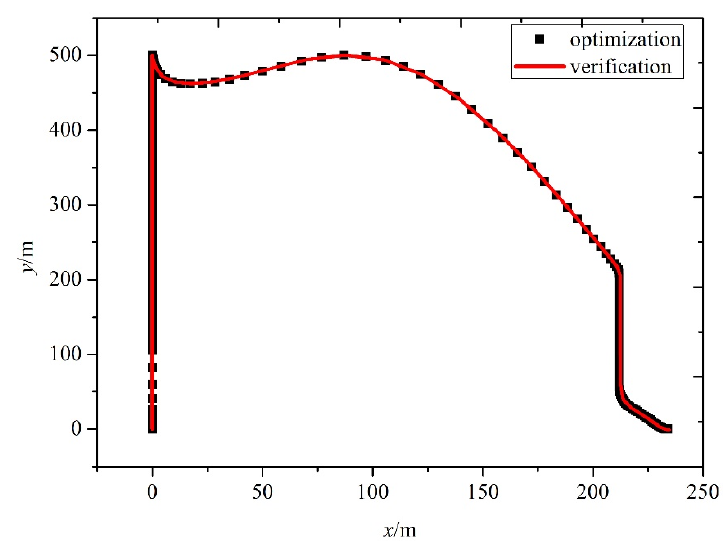
Figure 17. Flight trajectory under case 2 in the third scenario.